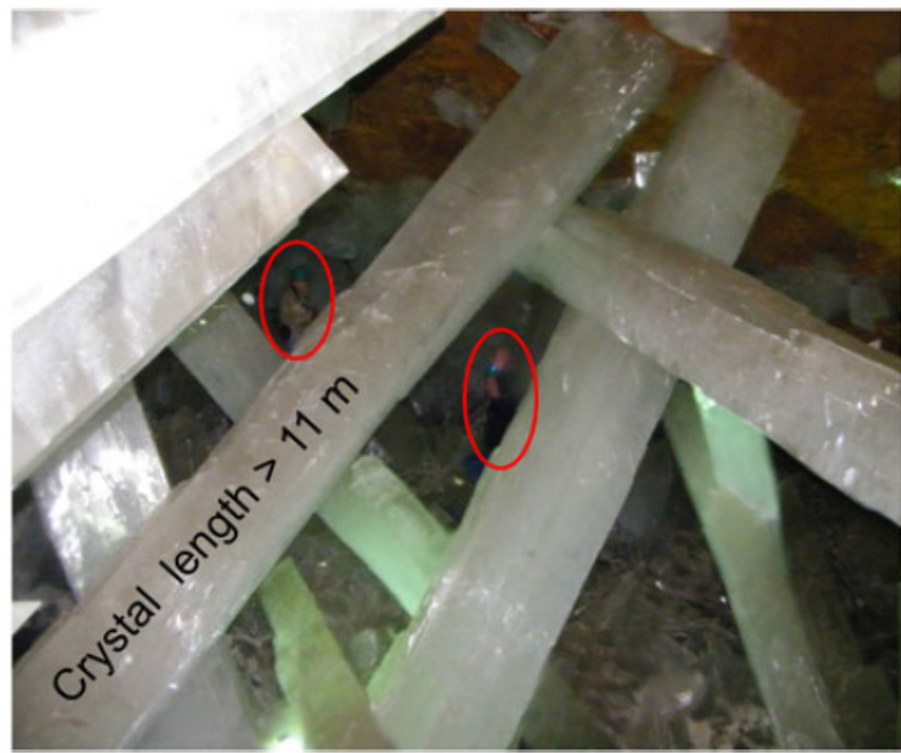
Figure 11. Giant gypsum crystals size compared to human size (encircled in red). Taken from Montero-Cabrera et al. (2020).